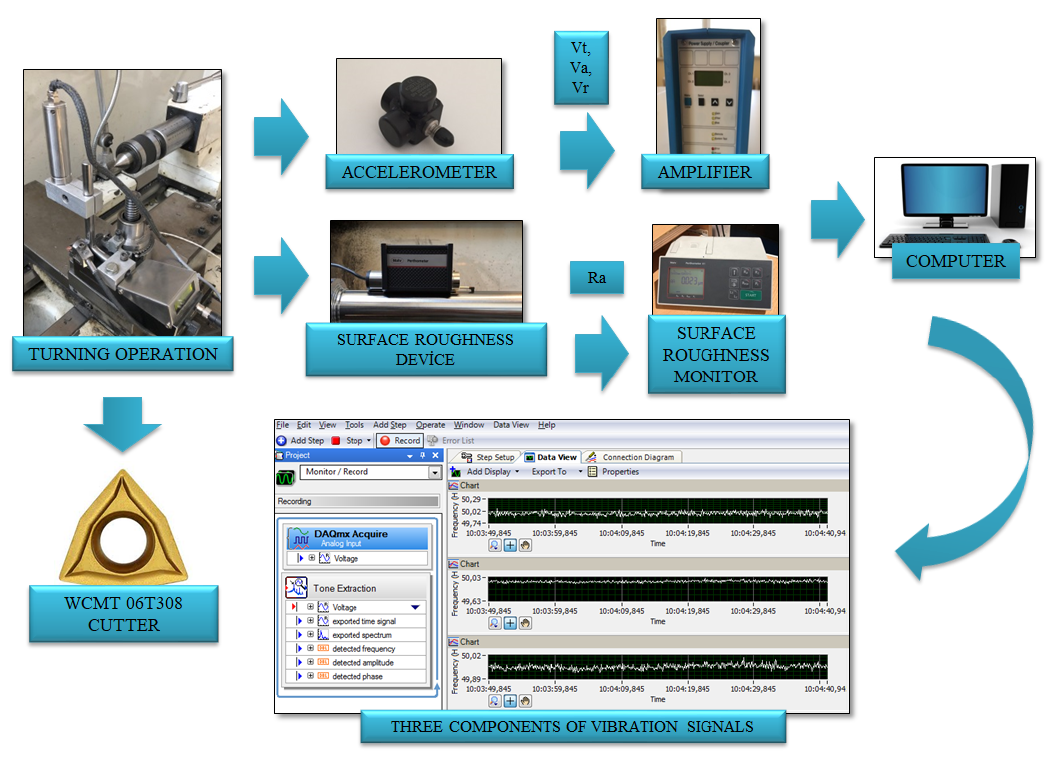
Figure 1. Experimental setup.